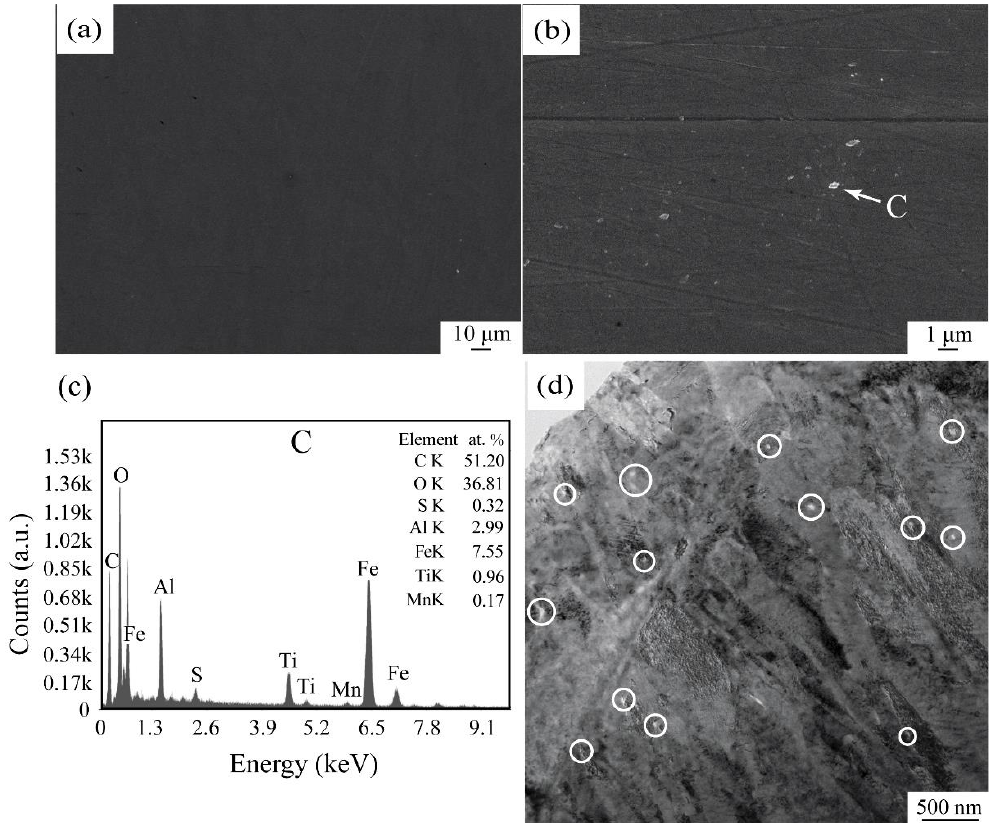
Figure 2. Distribution of the oxide particles in the 45 steel with oxide addition ( a ), ( b ) and ( d ). ( c ) is EDX result of the points C in ( b ).